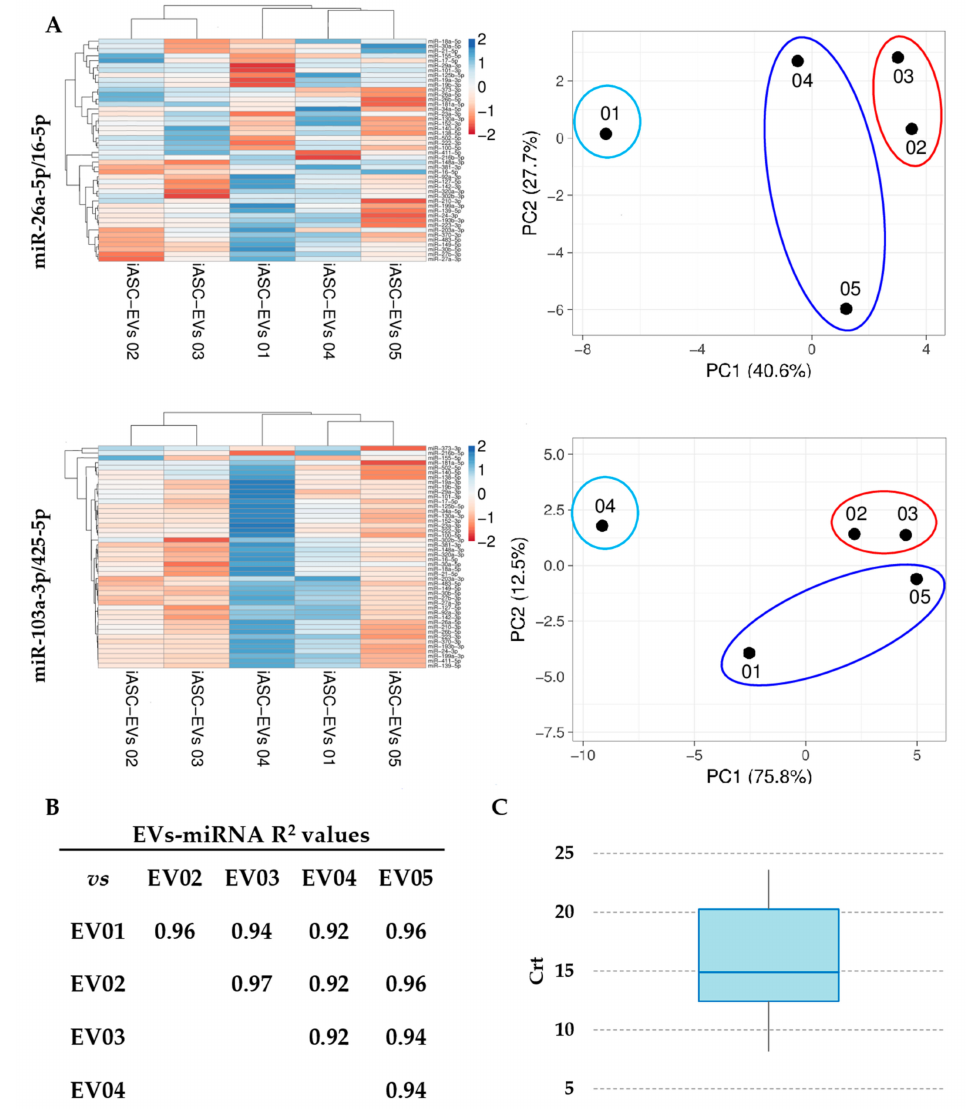
Figure 3. Influence of RG selection on iASC-EVs miRNA profile. ( A ) Heatmap of hierarchical clustering analysis and principal component analysis of the Crt values of 46 iASC-EVs miRNAs after stable miR-26a-5p / 16-5p or unreliable miR-103a-3p / 425-5p normalization. Rows were centered. Each row represents a miRNA and each column represents a sample. The sample clustering tree is shown at the top. The color scale shown in the map illustrates the relative expression levels of miRNAs across all samples: red shades represent high expression levels (low Crt) and blue shades represent lower expression levels (high Crt). miRNAs from the heat maps are shown in Supplementary Table S2. ( B ) Correlation of miRNA expression levels (normalized Crt) between the five iASC-EVs under study. ( C ) Box-plot of mean normalized Crt values for 46 miRNAs embedded in